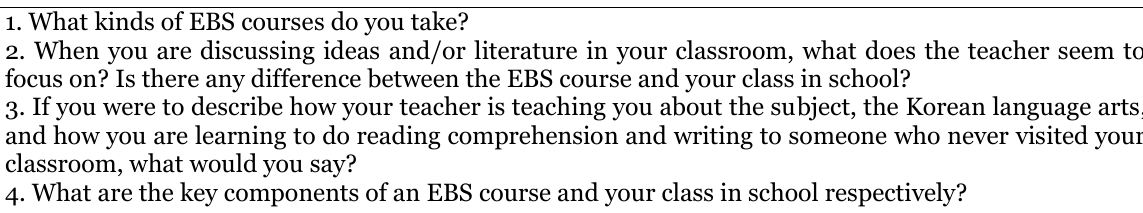
Figure 4 . Interview protocol for students. (Source: From Smagorinsky et al.’s (2013) interview